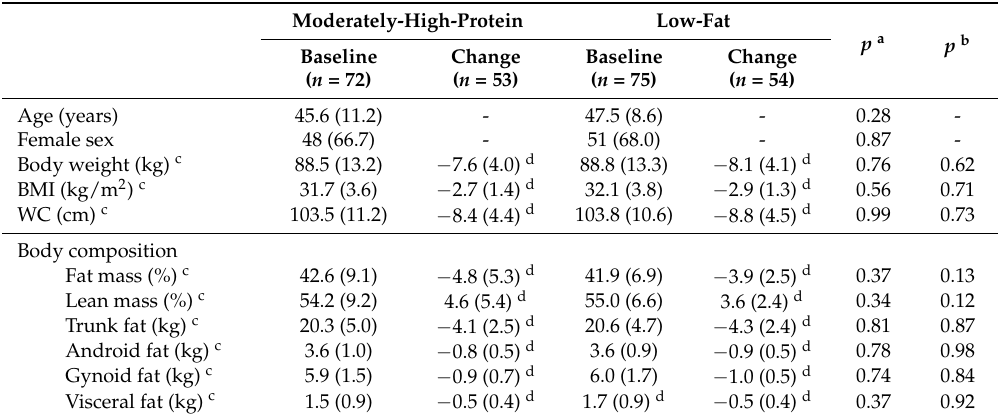
Table 1. Characteristics at baseline and after 16 weeks of intervention concerning anthropometric and body composition